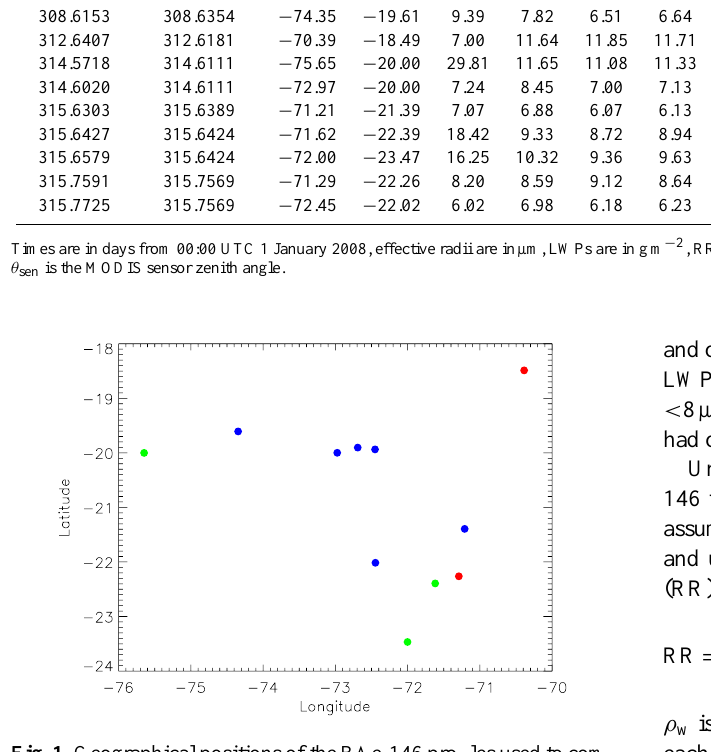
Fig. 1. Geographical positions of the BAe-146 profiles used to com- pare to MODIS